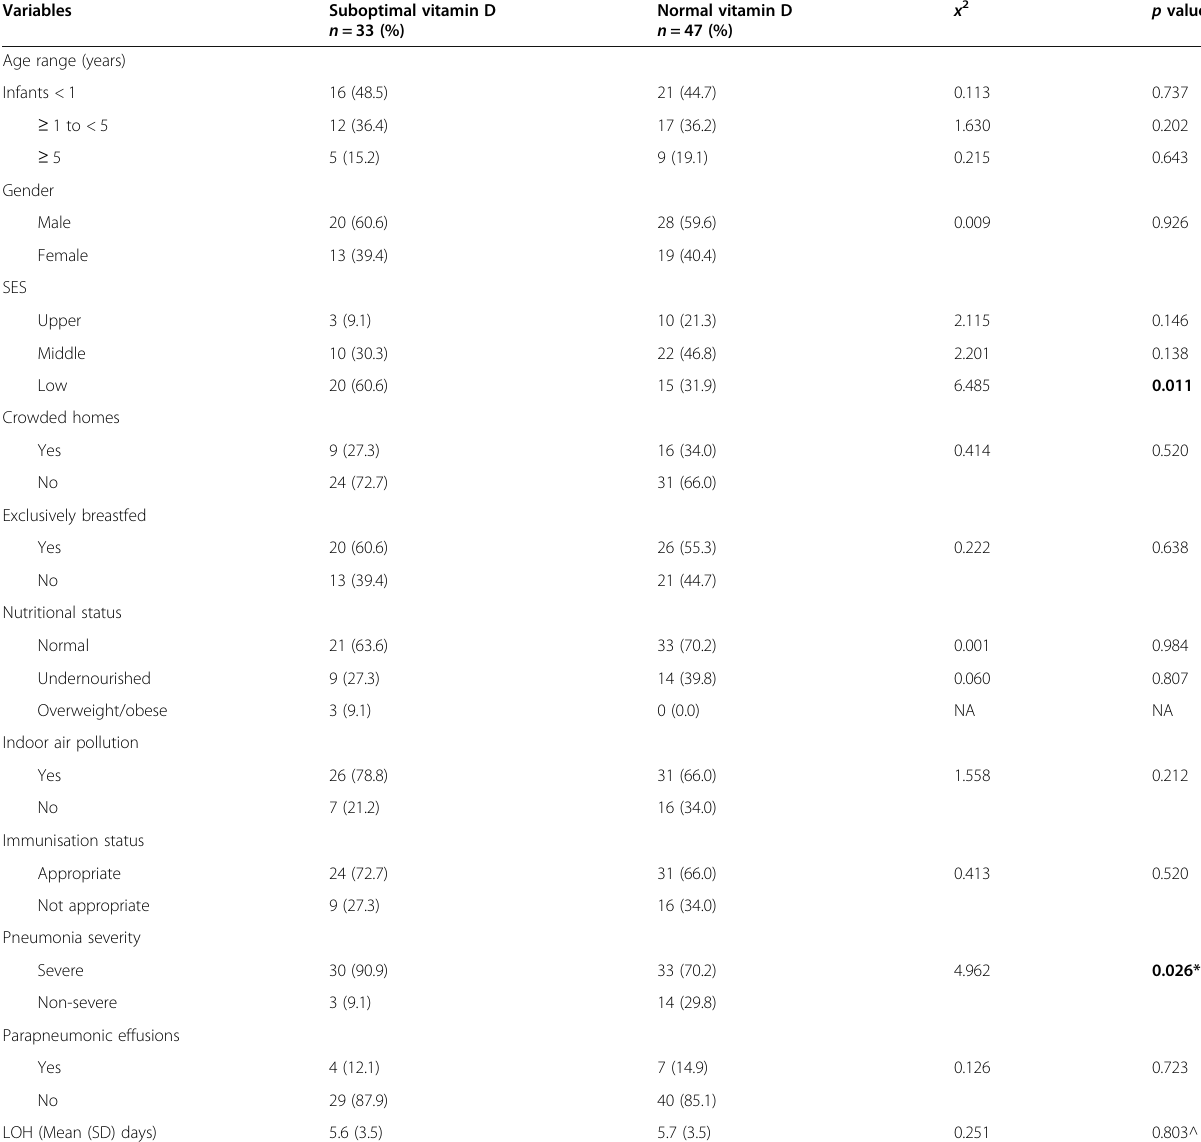
Table 3 Factors associated with suboptimal vitamin D levels in children with pneumonia Variables